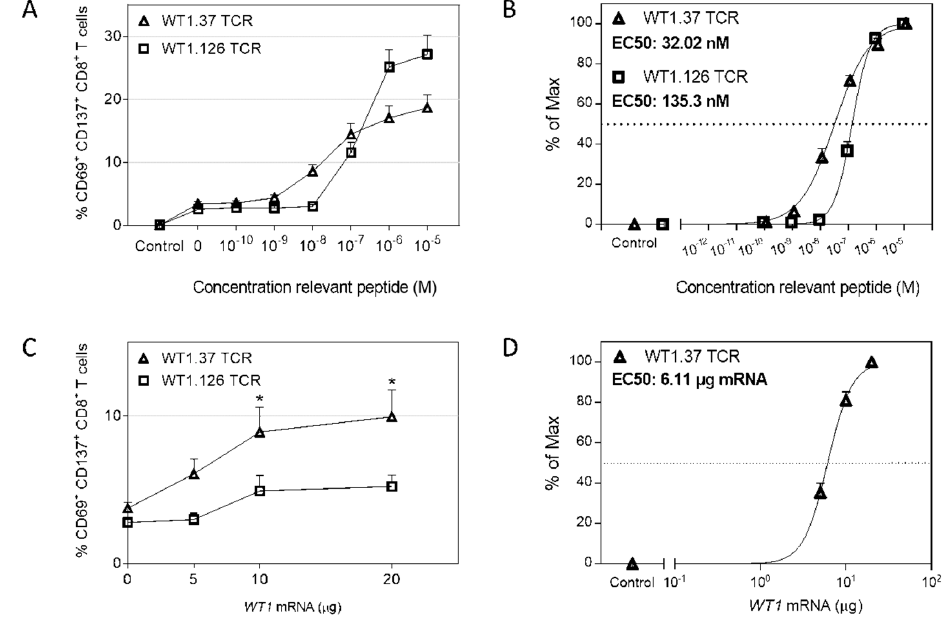
Figure 4. Analysis of functional avidity of WT1 epitope-specific primary CD8 T cells using WT1 peptide-pulsed and WT1 mRNA-electroporated U266 cells. Surface expression of both CD69 and CD137 activation markers was measured on WT1.37 (triangles) and WT1.126 (squares) peptide-specific DSE-engineered primary CD8 T cells 24 h after co-culture with U266 cells that were either pulsed with decreasing ( A , B ) concentrations of WT1 37–45 or WT1 126–134 peptide, or WT1 mRNA-electroporated ( C , D ). T cells only condition was used as a control. Graphs show mean ± SEM of % CD69 / CD137 double positive CD8 T cells ( A , C ) or % of maximal CD69 / CD137 expression ± SEM ( B , D ) for 6–8 donors. EC50, the concentration of WT1 peptides or amounts of electroporated WT1 mRNA at which 50% of the maximal upregulation of CD69 and CD137 activation markers is reached. ( A , C ) One-way ANOVA followed by Dunnett’s post hoc test (comparing to non-peptide pulsed or mock-electroporated cells). *, p <